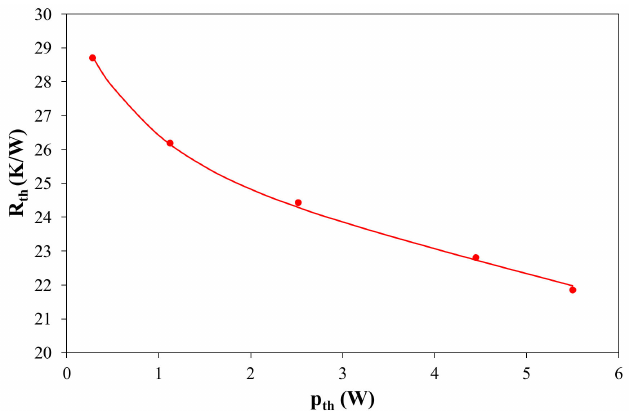
Figure 8. Measured and modelled dependences of the thermal resistance of the resistor operating without any cooling system on the power dissipated in this resistor (system A).